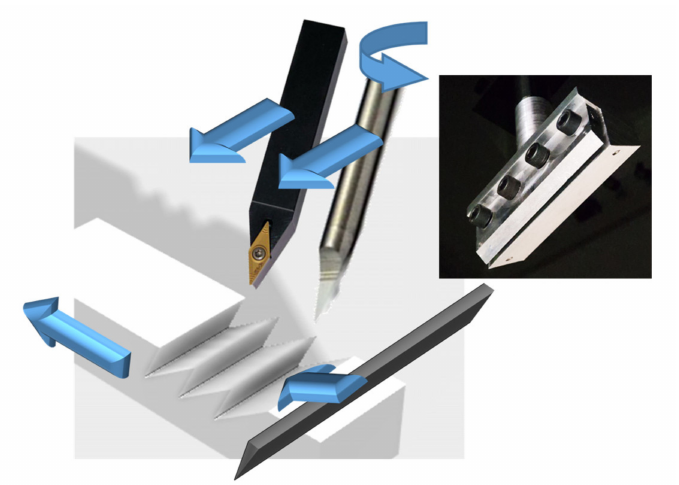
Figure 2. Overview of the cutting strategy to fabricate a permanent mold by a special blade and its support (inset). The alternative strategy providing the results in Figure 3 entails a chisel or a traditional single point tool along the transverse direction. A range of materials was tested using low viscosity mineral oil (WD-40) as the lubricant. Plastic and metals were tested for different objectives, which is explained in the next section, and for performance comparison of the tested solutions.